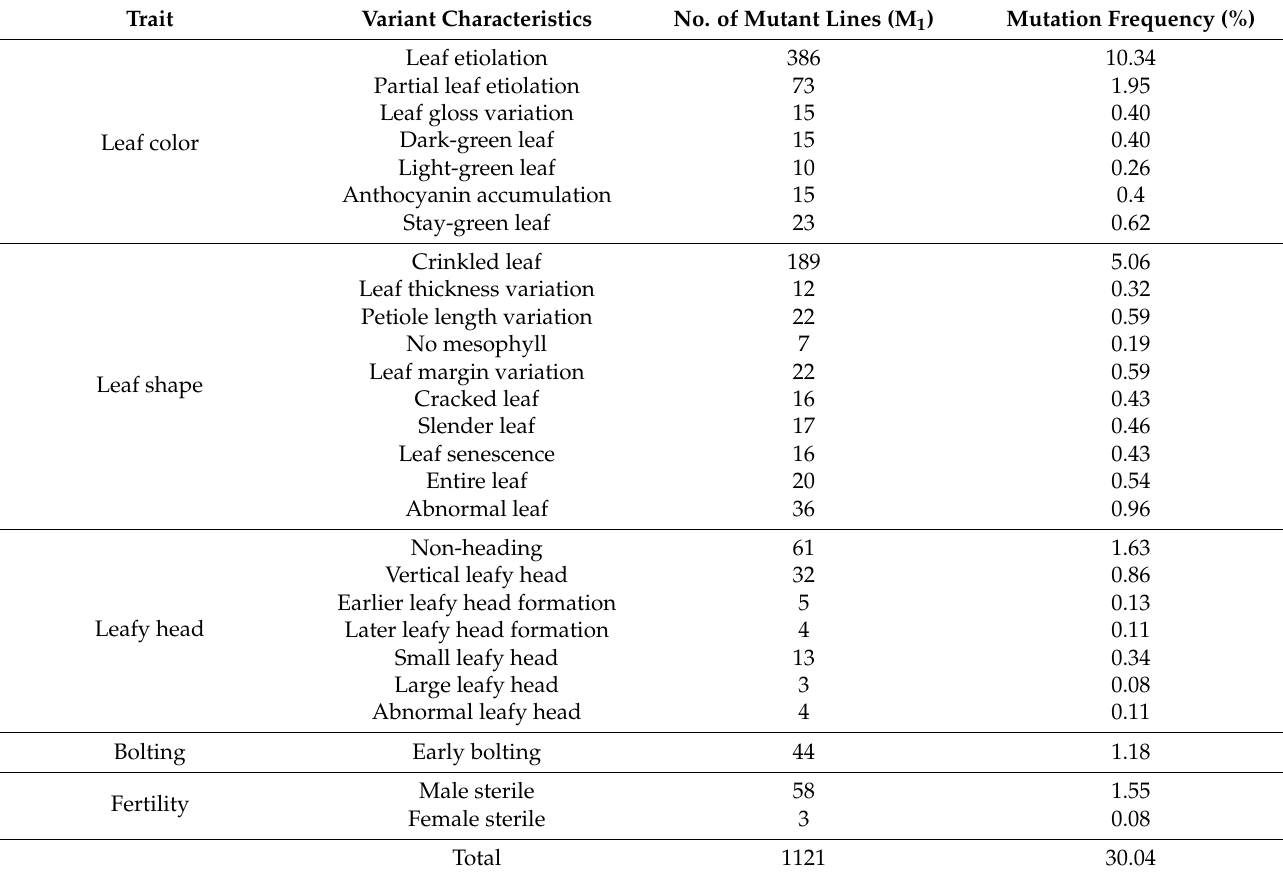
Table 3. Characterization of mutation types in M 1 plants of Chinese cabbage (seed EMS mutagenesis).